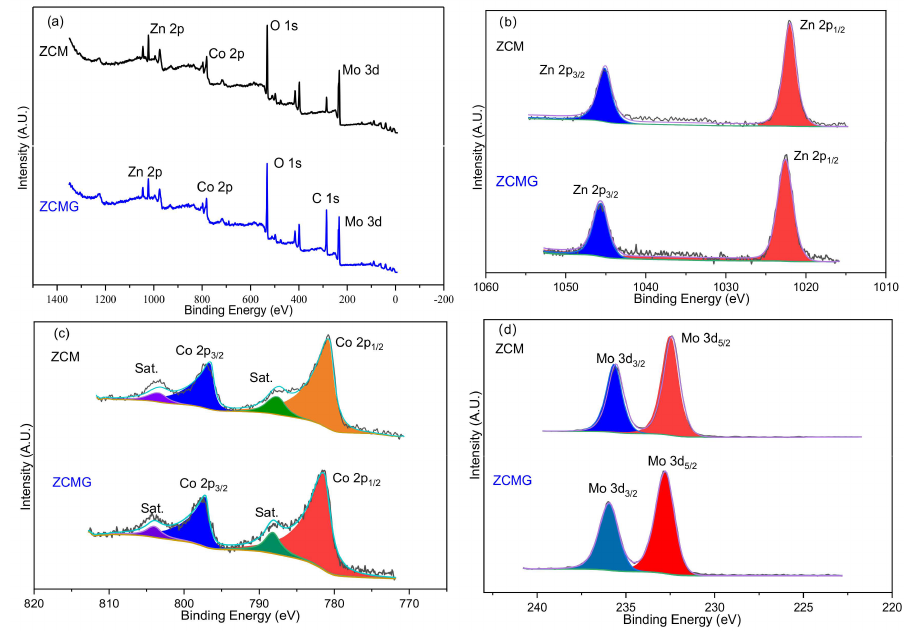
Figure 6. XPS spectra of ZCM and ZCMG. ( a ) XPS Survey, ( b ) Zn 2p, ( c ) Co 2p, ( d ) Mo